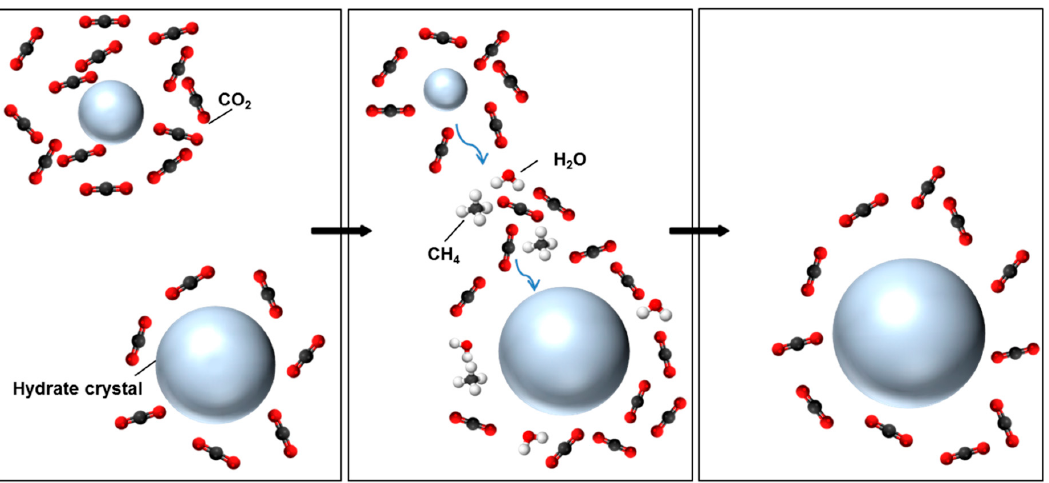
Figure 12. Schematic illustration of the growth of CH 4 –CO 2 mixed hydrate at the expense of smaller hydrate crystals considering the Ostwald ripening effect. The left panel indicates a CO 2 molecular concentration gradient between the large and small hydrate crystals based on the Gibbs–Thomson effect. Therefore, the diffusion of CO 2 molecules due to the concentration gradient is initiated from the small crystal towards the large crystal together with CH 4 molecules and water molecules so as to minimize the surface area and lower the free energy. Finally, the large crystal grows and the small crystal disappears, as shown in the right panel.